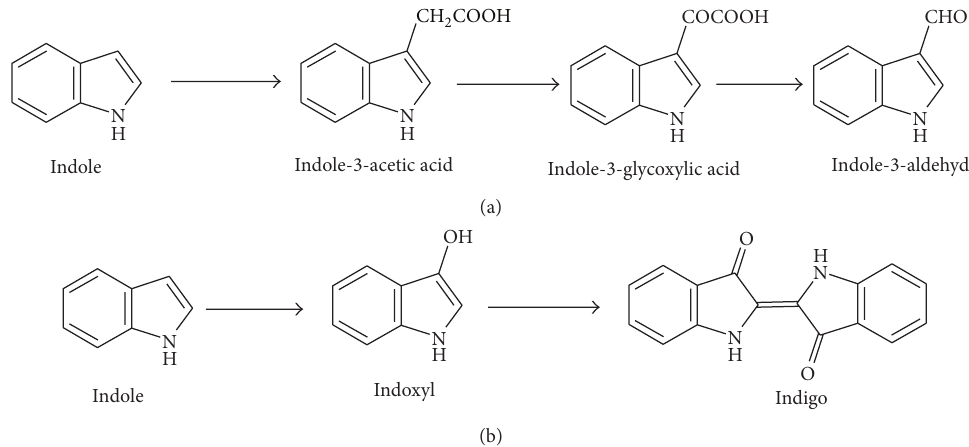
Figure 3: Biotransformation of indole to indole-3-aldehyde (a) and indoxyl